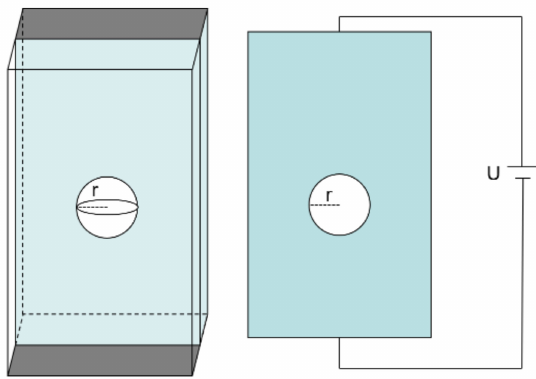
Figure 4. 3D single bubble model in liquid nitrogen.